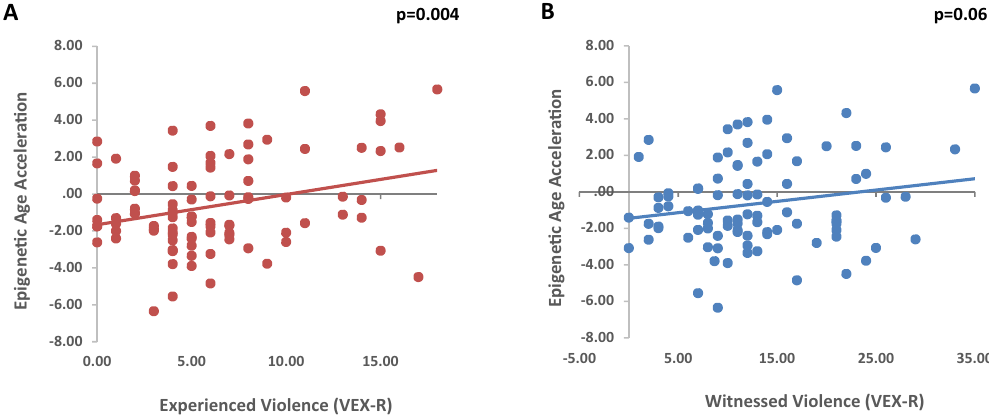
Figure 1. Scatter plots and regression lines for the association ( A ) between age acceleration and experienced violence (r = 0.30, p = 0.004), and ( B ) between age acceleration and witnessed violence (r = 0.19, p = 0.06). Age acceleration was defined by taking the residual of the linear regression of DNAm age on chronological age.